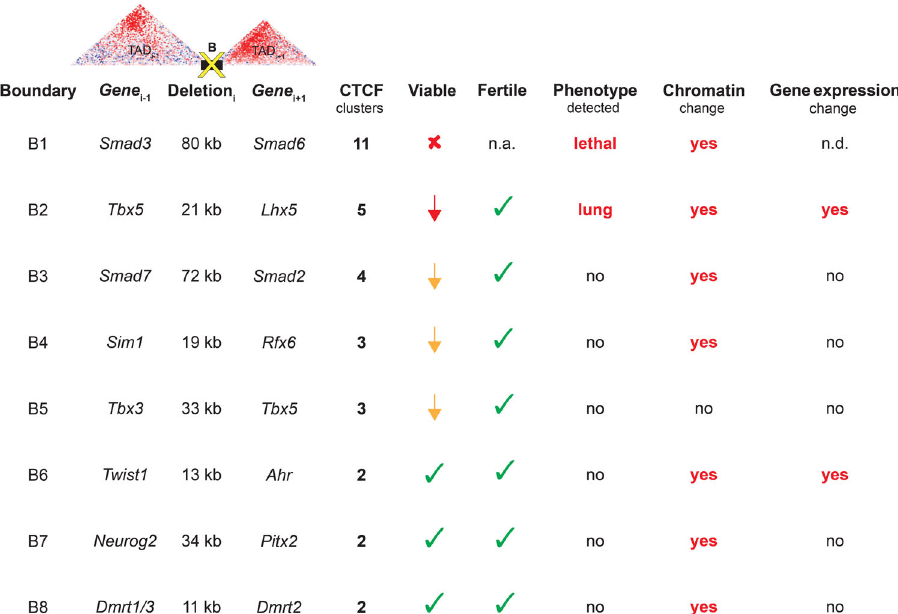
Fig. 5 Summary of fi ndings. Columns show speci fi c TAD boundaries (B1 – 8) deleted in this study, key developmental genes within the fl anking TADs (Gene i-1 and Gene i + 1 ), approximate boundary deletion sizes (Deletion i ), and the number of putative CTCF clusters deleted. All data in subsequent columns are summaries of phenotypic information for mice homozygous for the respective TAD boundary deletions. These include effects on viability (fully lethal in red cross mark, subviable shown in red or yellow arrow to indicate magnitude of effect, no deviation from expected Mendelian ratios shown in green check marks), fertility of both male and female homozygous animals (at least three homozygous males and three homozygous females were assessed for reproductive fi tness, green check marks indicate fertile animals), and overt physiological phenotypes observed. Column for chromatin change indicates presence of signi fi cant DI changes and/or signi fi cant alterations to intra-domain chromatin contact frequencies in the fl anking TADs, assessed by Hi-C. The last column indicates whether signi fi cant expression changes were observed for genes in the vicinity of the deleted TAD boundary. n.a. not applicable, n.d. not